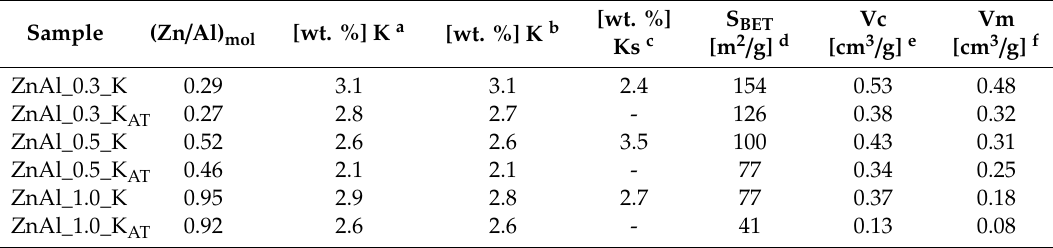
Table 1. The chemical compositions and textural properties of the ZnAl_X_K and ZnAl_X_K AT catalysts with di ff erent Zn / Al molar